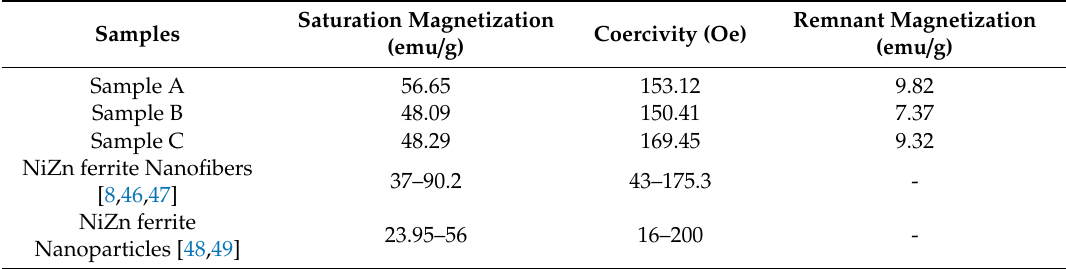
Table 5. Saturation magnetization, coercivity, and remnant magnetization of Ni 0.5 Zn 0.5 Fe 2 O 4 nanofibers measured from samples A, B, and